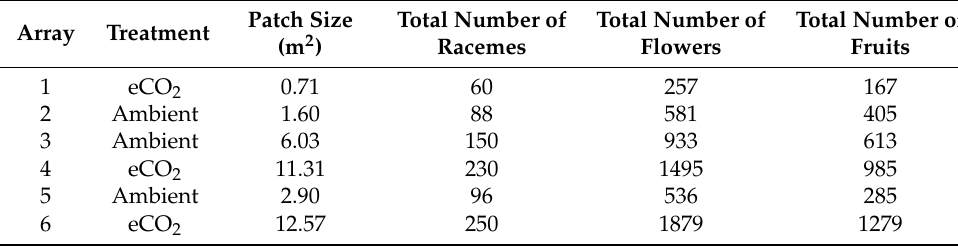
Table 1. Bluebell patch metrics for each experimental